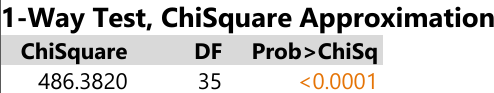
Figure 3. Results of Kruskal-Wallis test.